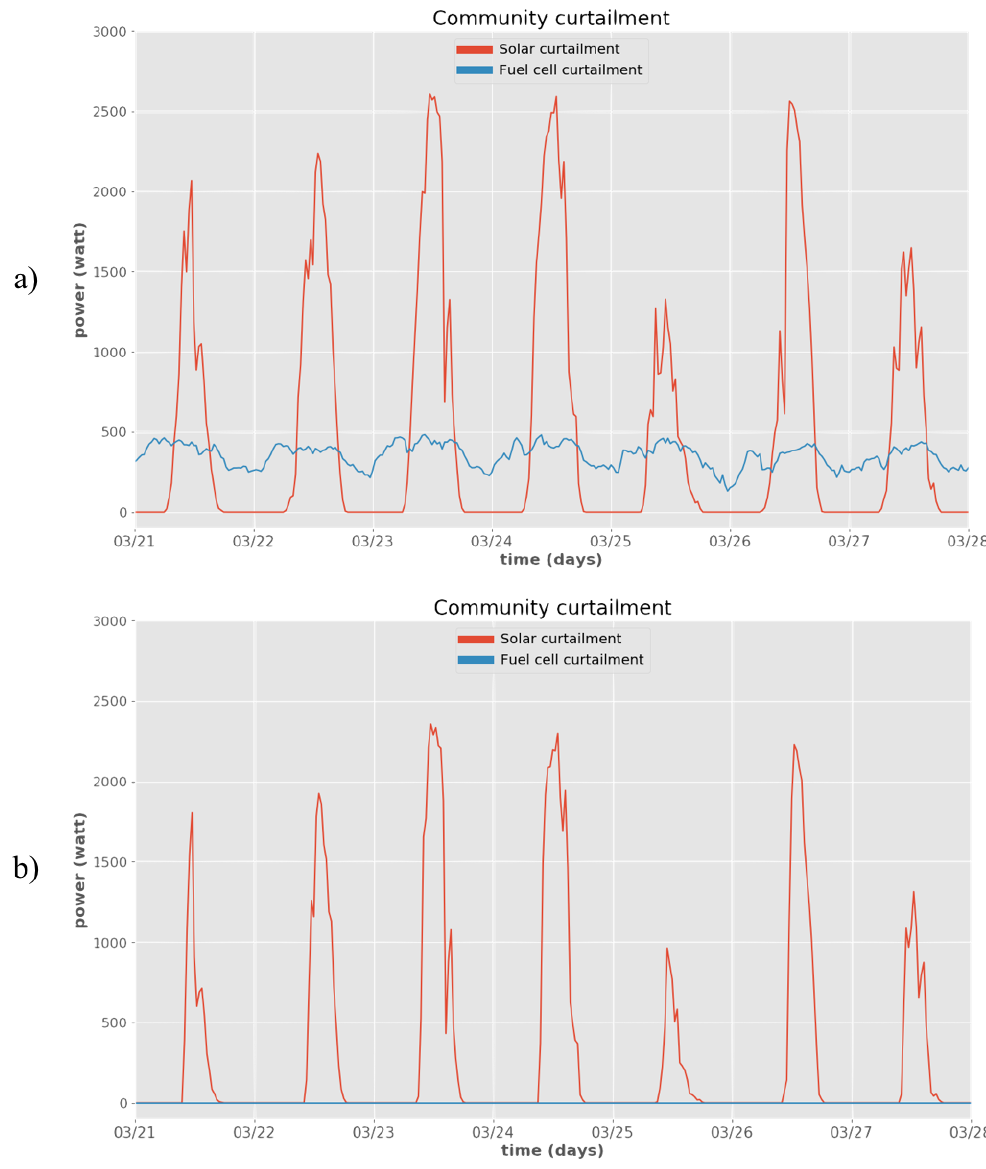
Figure 8. Average curtailment in community, comprised of standalone houses with solar panels and fuel cells, using priority-based internal agent ( a ) without fuel cell scheduling function and ( b ) with added scheduling